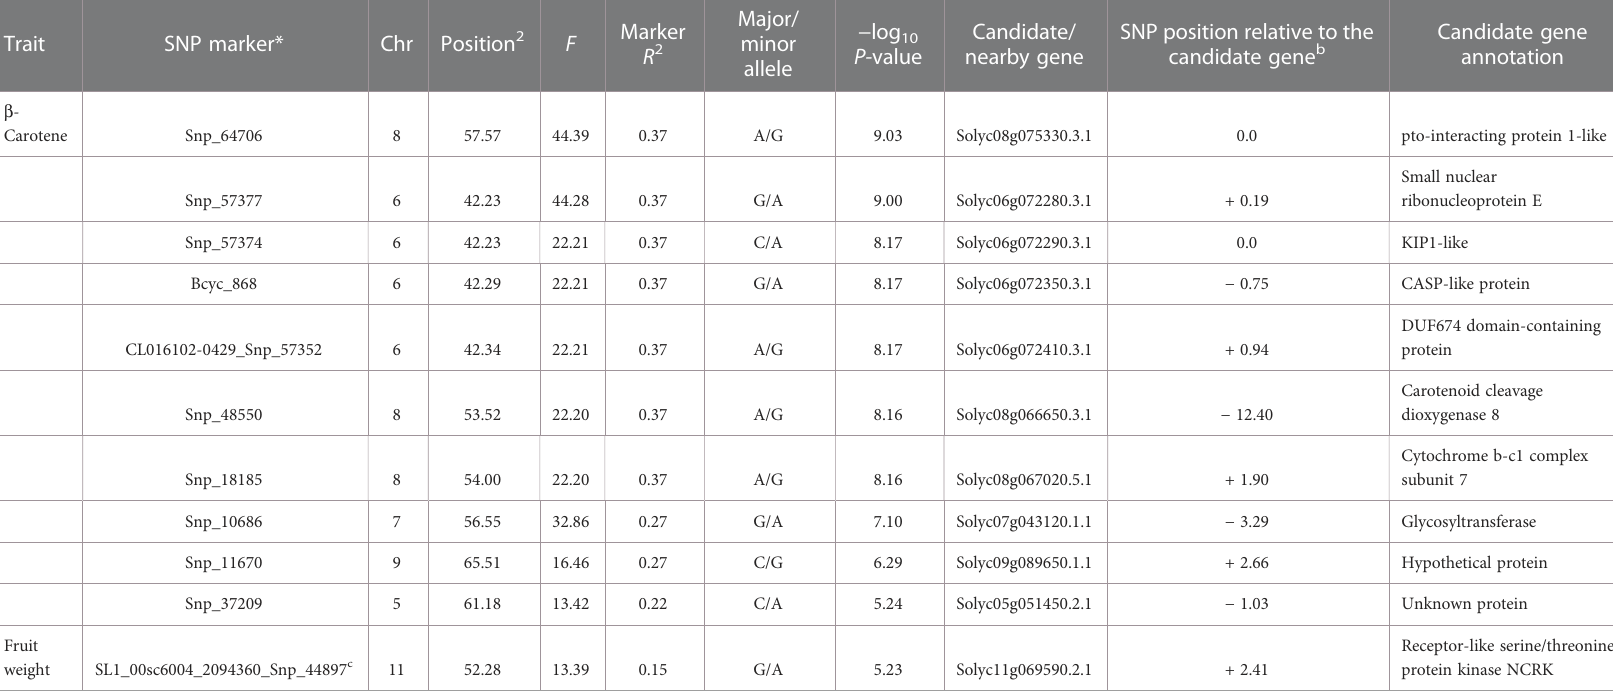
TABLE 4 Signi fi cant marker – trait associations detected traits using both general and mixed linear models. Trait SNP marker* Chr Position 2 F